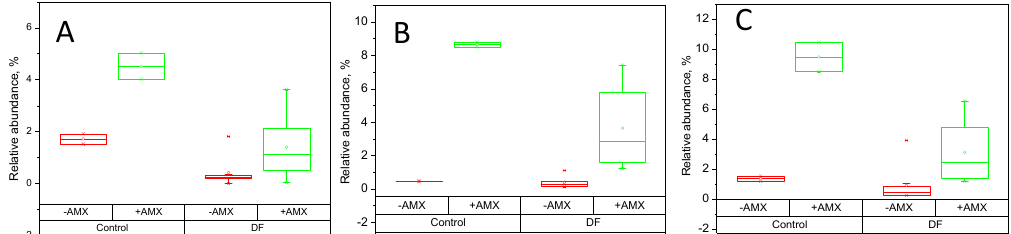
Figure 4. The relative abundance of selected families in the samples with ( + AMX, green) and without ( − AMX, red) amoxicillin-clavulanate after 48 h of fermentation of RS and experimental fiber preparations. ( A ) Porphyromonadaceae (p_Bacteroidetes), ( B ) Peptostreptococcaceae (p_Firmicutes), ( C ) Sutterellaceae (p_Proteobacteria).